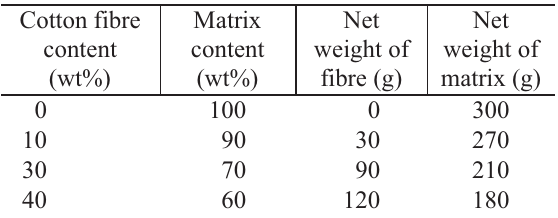
Table 1. PP/CF hybrid composite formulation